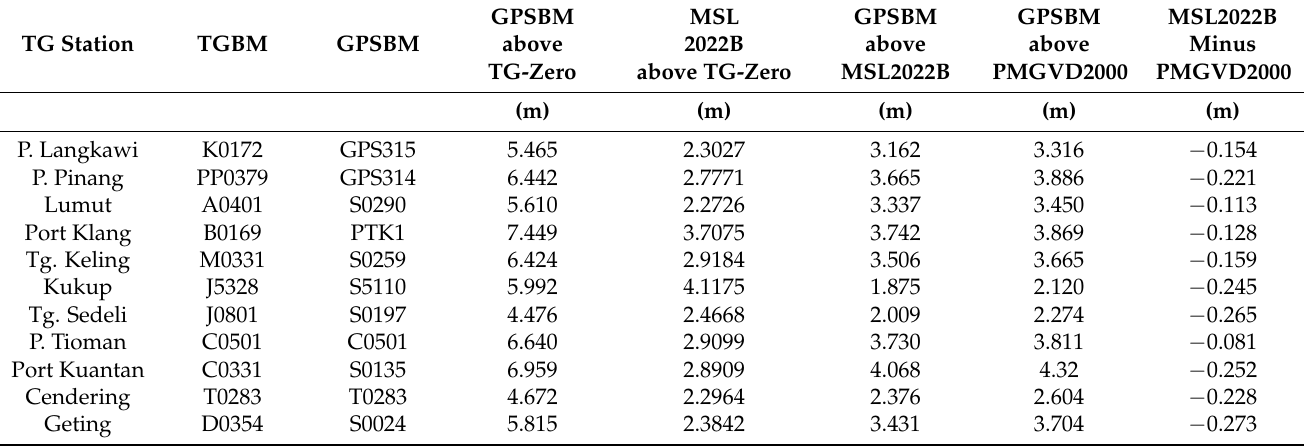
Table 6. GPS benchmark (GPSBM) heights above the new vertical datum